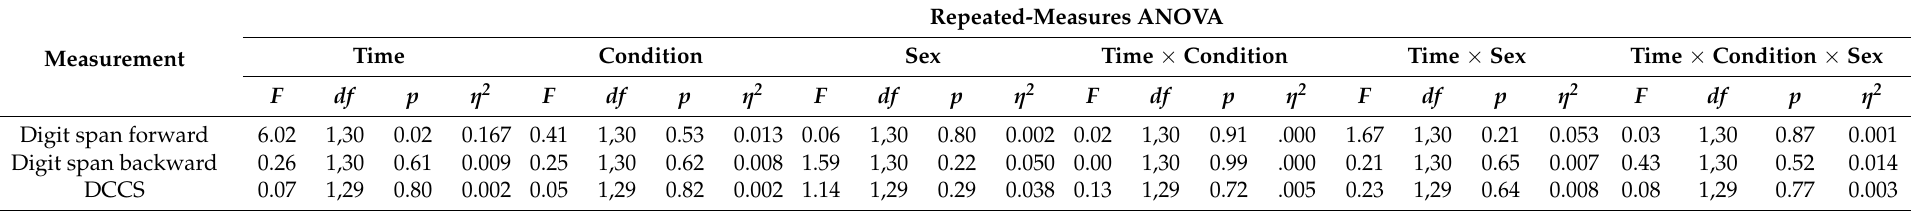
Table A5. Effects of the intervention on short-term memory, working memory and shifting skills.